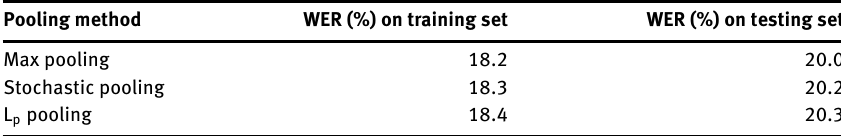
Table 4: WER as a Function of Pooling in Frequency and Time. Pooling